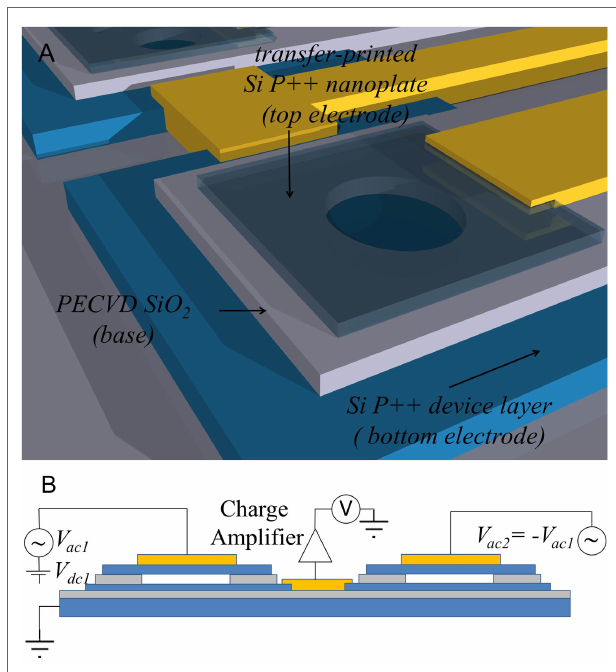
FigUre 1 | (a) Illustration of the device. (B) Cross-sectional view showing the electrical scheme used to enable the electrostatic actuation of the plate and the capacitive detection of its resonance